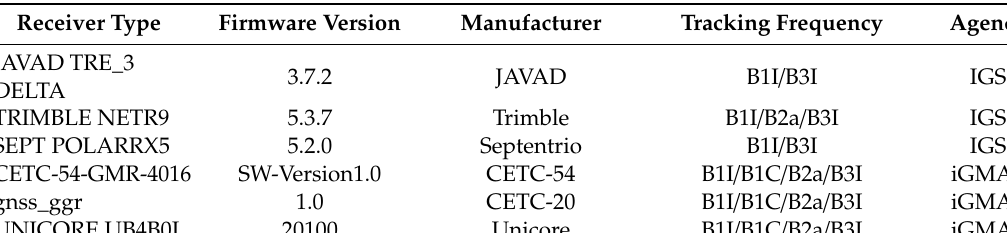
Table 1. Information about the third generation of BeiDou (BD3) satellites capable receivers.